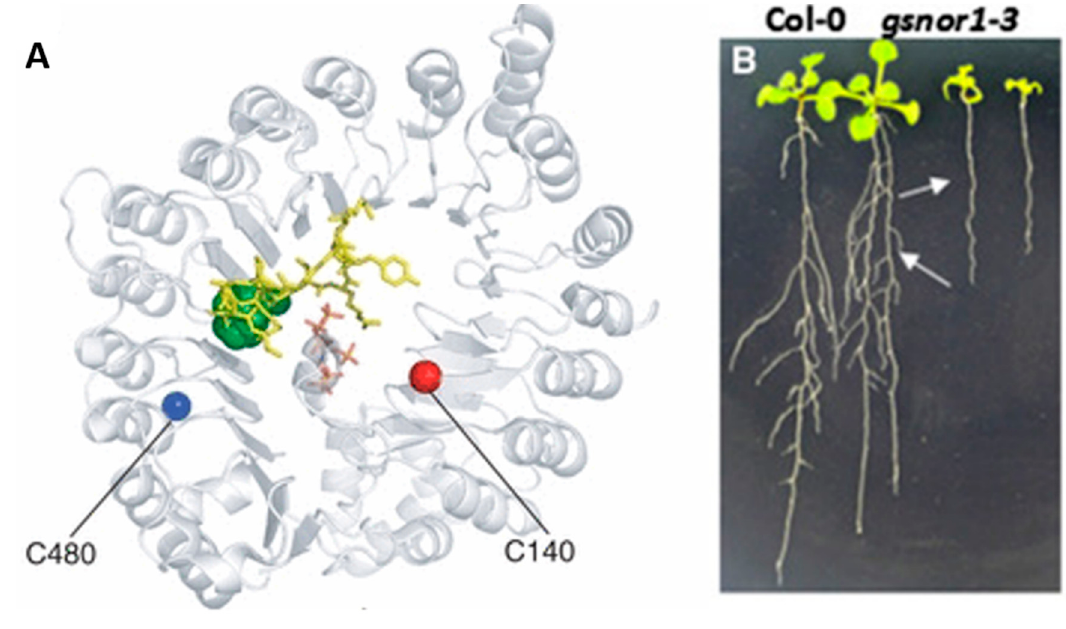
Figure 6. Possible S-nitrosation site on TIR1 not consistent with phenotype of GSNOR 1–3 mutant [1,44]. ( A ) shows S-nitrosylation sites on TIR1 thought to be capable of upregulating auxin production hypothesized to increase growth however ( B ) shows that in application the GSNOR knock out leads to stunted growth, evidence in favor of GSNORs pleiotropic effects.